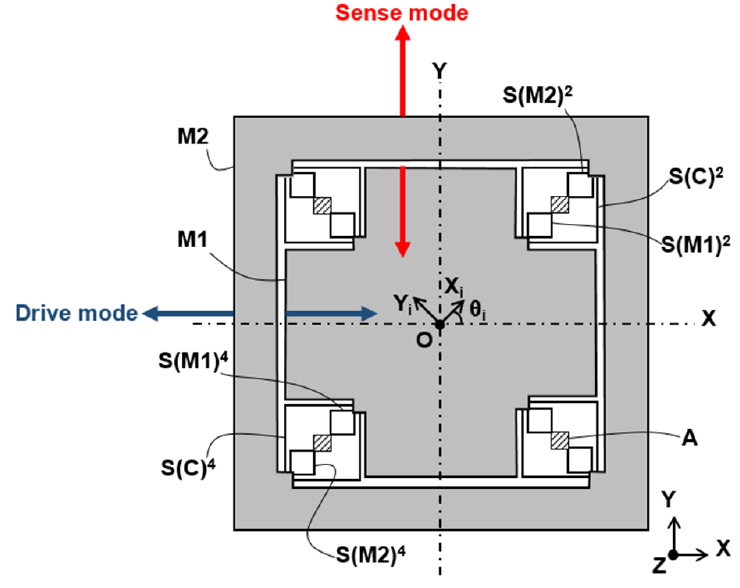
Figure 1. Conceptual view of the gyroscope [34].